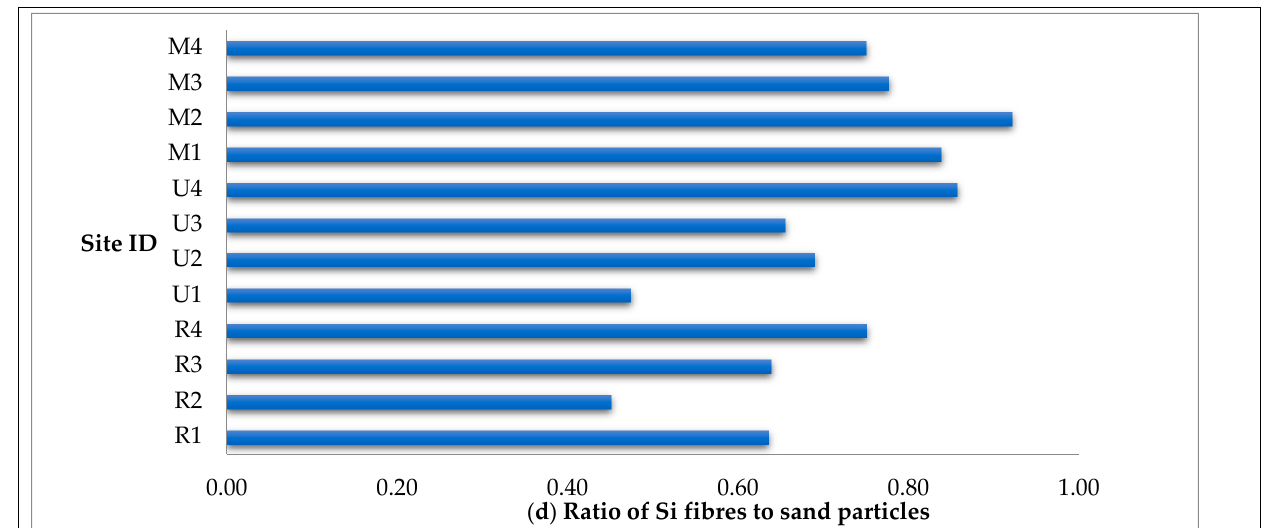
Figure 8. The classified particles are divided into four groups based on settlement: ( a ) urban, ( b ) mixed, and ( c ) rural ( d ) A Comparism diagram of the ratio of Si fiber to sand fibres for all sites.